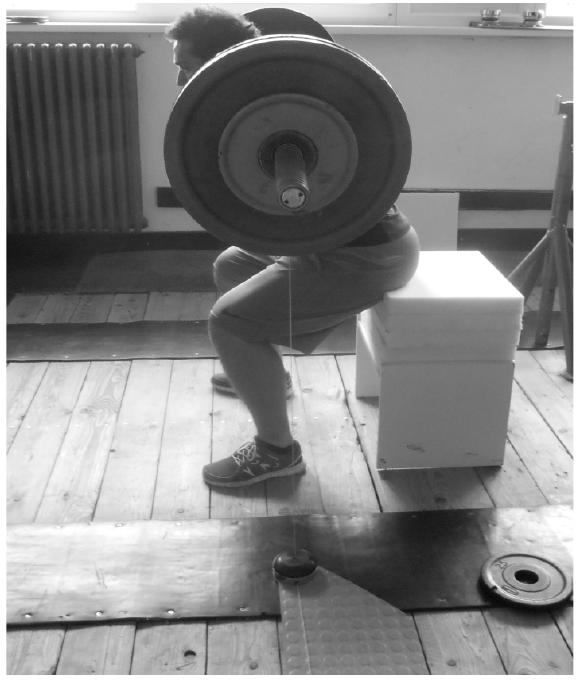
Figure 2. Individually adjusted foam cubes to control the range of motion (90° in knee joint) and placement of the Tendo Power Weightlifting Analyzer on the floor and attachment via kevlar cord to the Olympic